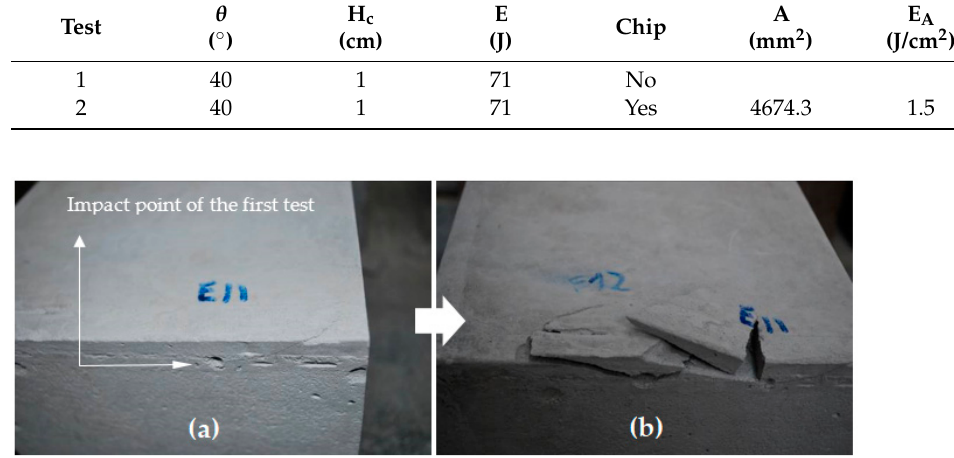
Figure 11. Influence of the affected zone. ( a ) Impact point of the first test. ( b ) Material removed after the second test.